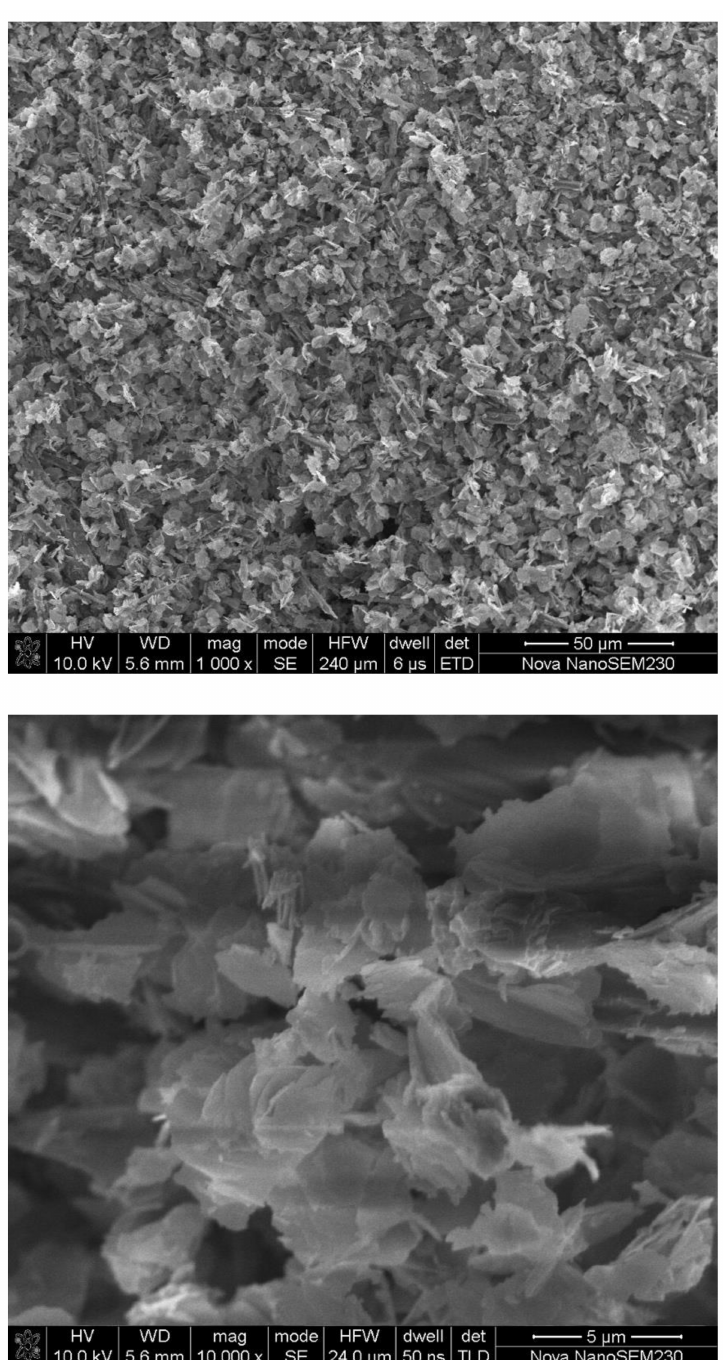
Figure 2. SEM images of